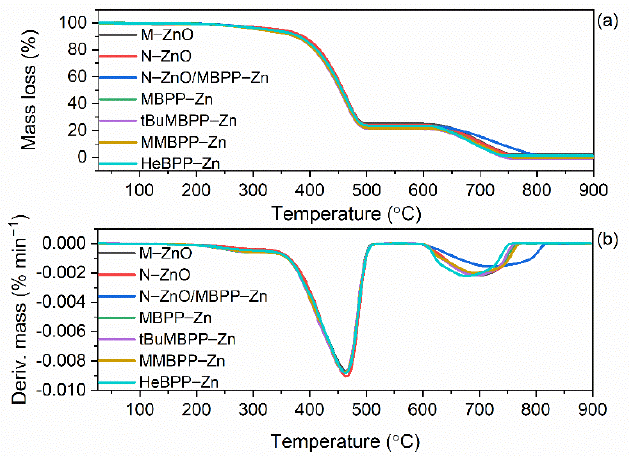
Figure 13. Thermogravimetric (TG) and Derivative Thermogravimetric (DTG) curves of SBR vulcanizates containing ZnO and zinc complexes with 1,3-diketones as activators: ( a ) TG curves; ( b ) DTG curves. Table 8. Onset temperature of thermal decomposition (T 5% ), DTG peak temperature (T DTG ) and total mass loss (∆m) during decomposition of SBR compounds containing ZnO and zinc complexes